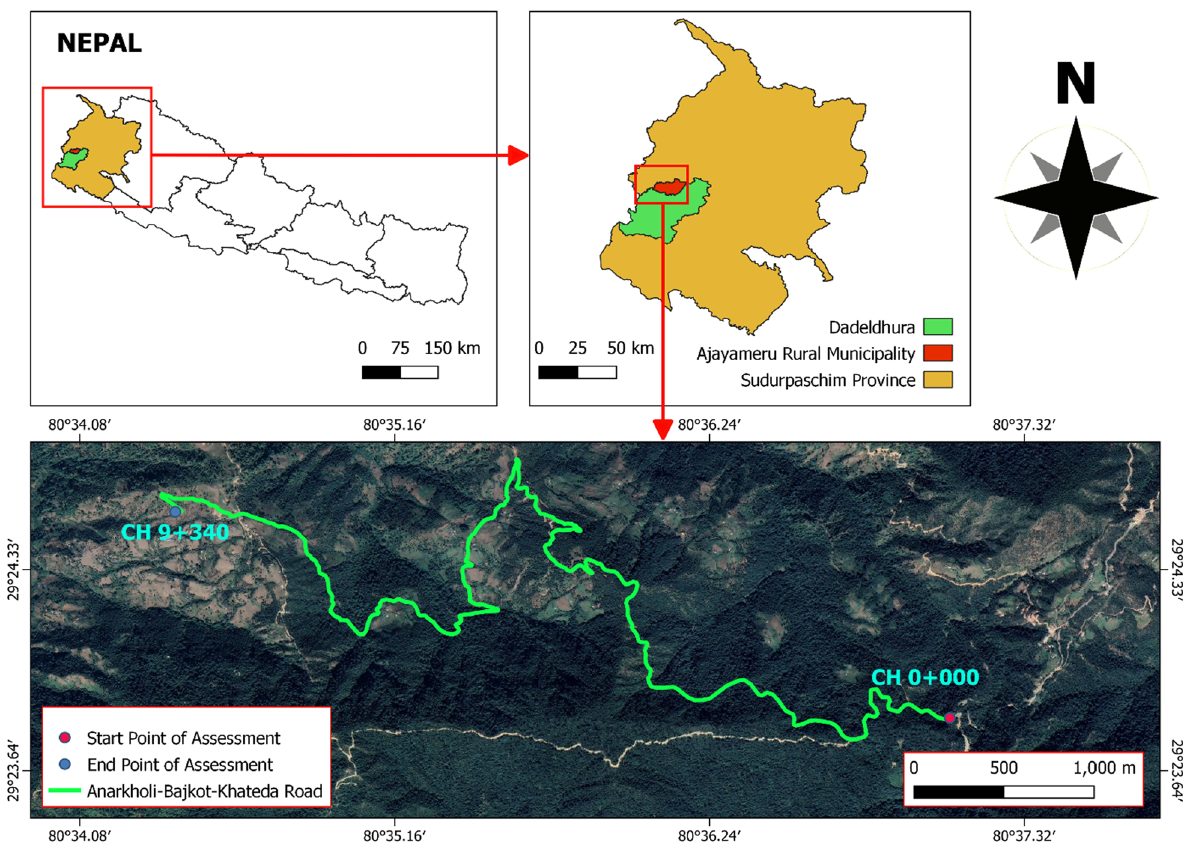
Fig. 4 Location map of Anarkholi-Bajkot-Khateda rural road, Ajayameru Rural Municipality, Dadeldhura,